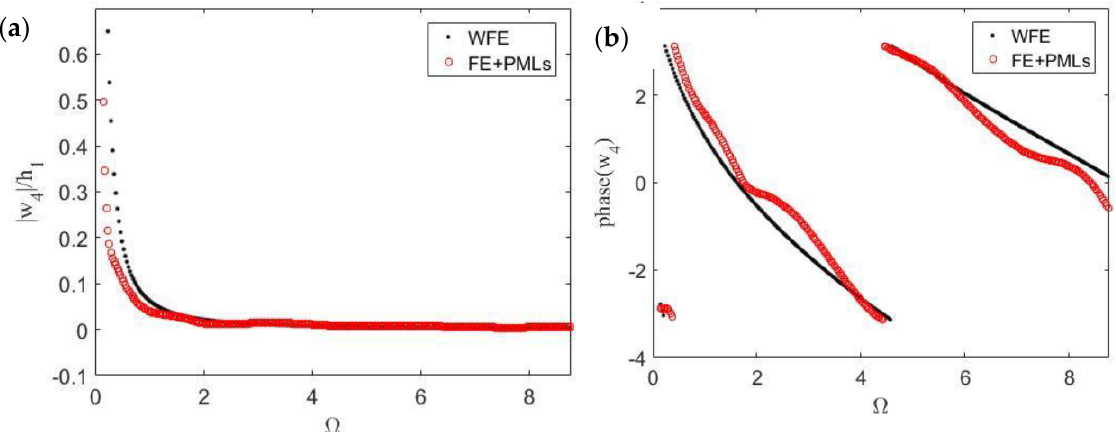
Figure 6. Response at the 4th cell of the radial periodic plate excited by harmonic transverse point forces at the border of the central hole, ( a ) absolute value; ( b ) phase. Comparison between the approximated WFE results FEM results.